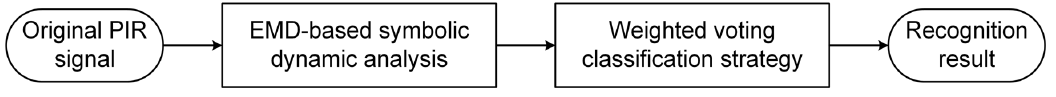
Figure 10. Recognition procedure of the outdoor pedestrian detection.